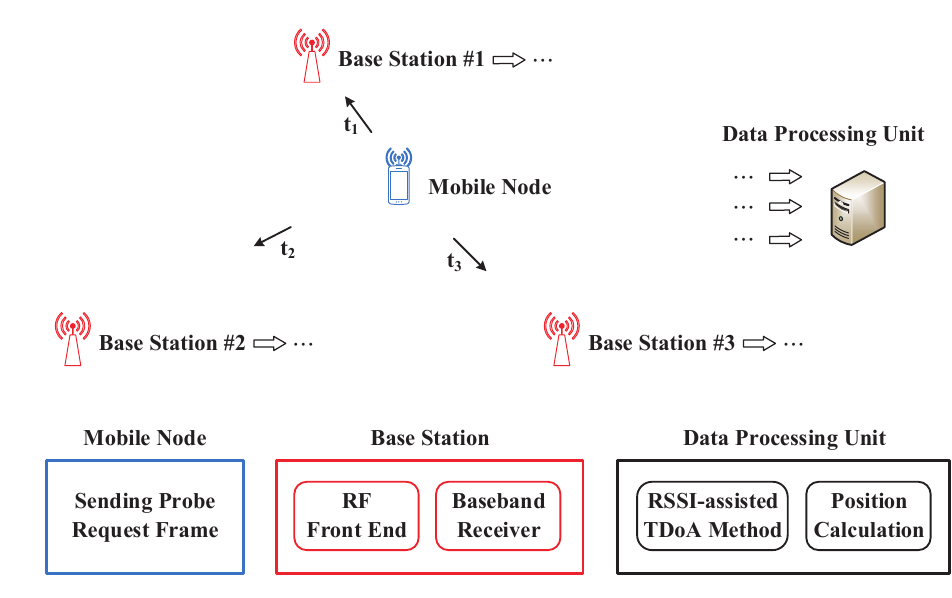
Figure 7. Overall system architecture.